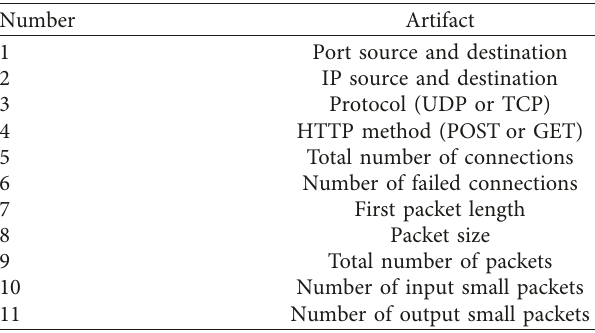
Table 4: Example of HTTP request and response ranges